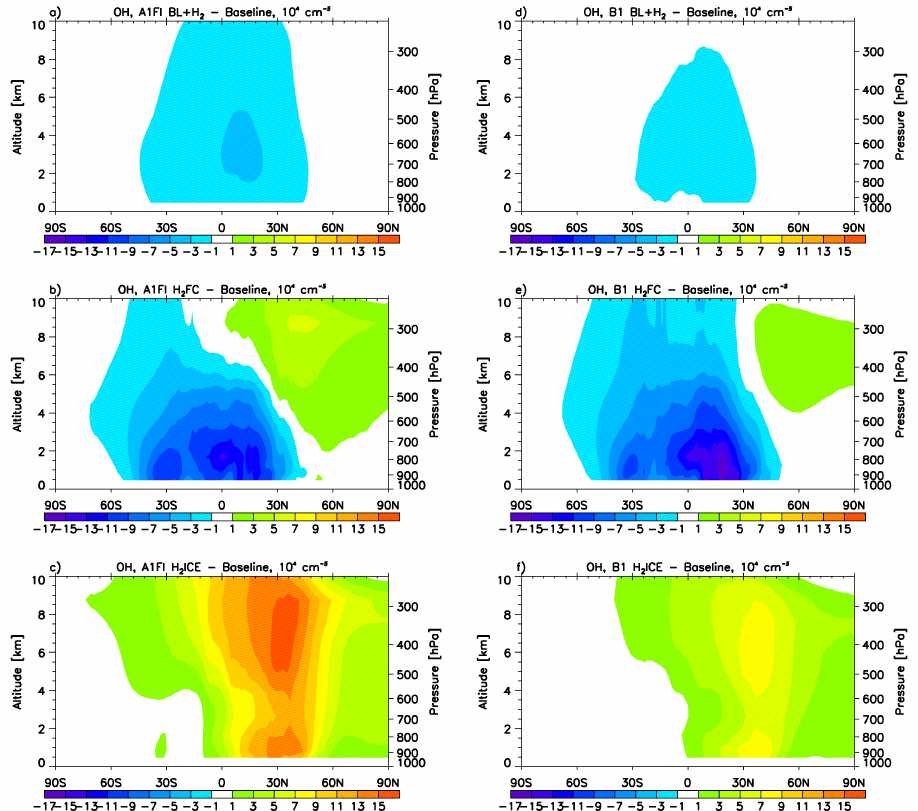
Figure 7. CAM-Chem simulated 2050 annual averaged zonal-mean OH abundance 2 differences in the H scenarios (10 -4 cm -3 ). Note the different scales. 4